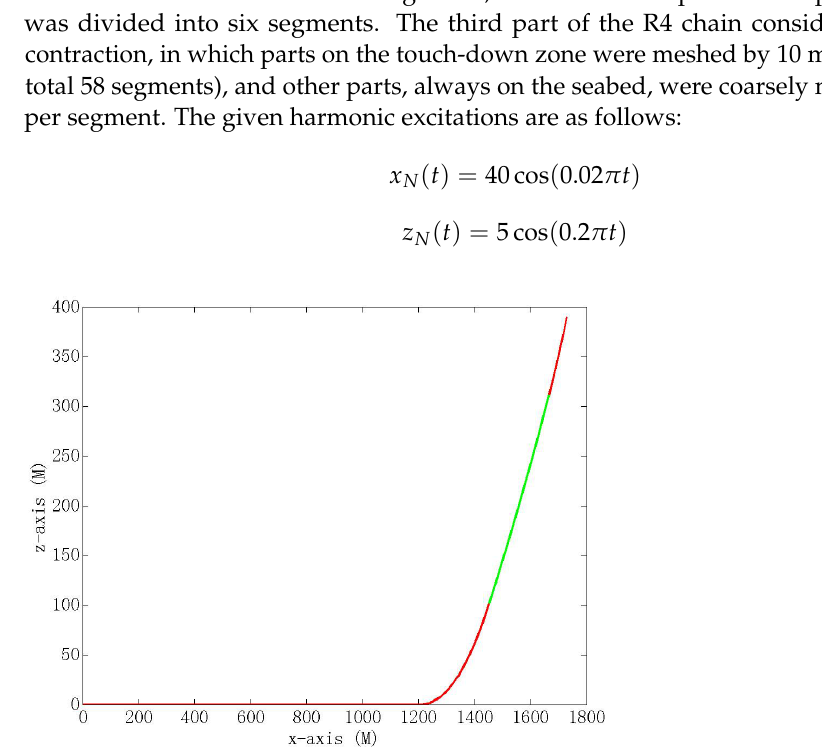
Figure 8. Single mooring line under combined vertical and horizontal harmonic excitation with